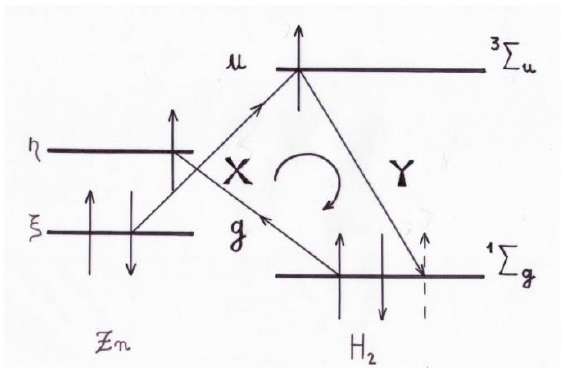
Figure 10. The XY Exchange-Coulomb conversion channel. ( a ) The molecule – solid electron exchange C = X excites simultaneously the molecule and the solid antibonding states (a two-electron excitation). In such an intermediate state of that singlet channel of mutual neutral states, the bonding (and antibonding) electrons have parallel spins. ( b ) In the next step of mutual electron and nuclear spin “flip - flop”, the molecular electrons transfer their spin momenta by hyperfine contact Y to the nuclei, converting the molecule, as represented in the Figure 5.